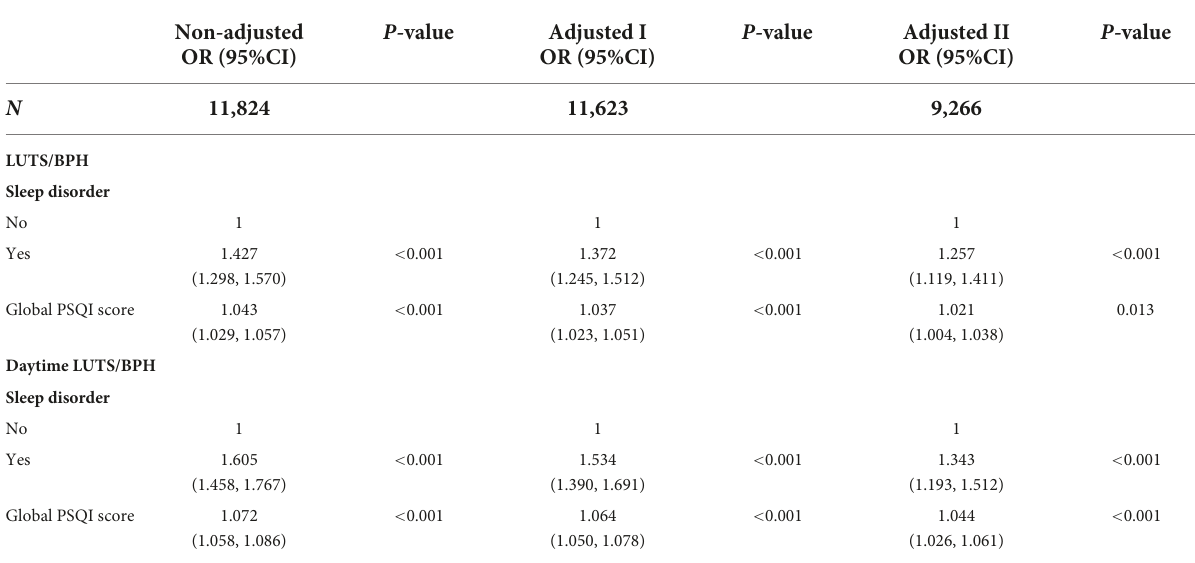
TABLE 2 Associations between sleep disorder and LUTS/BPH and daytime